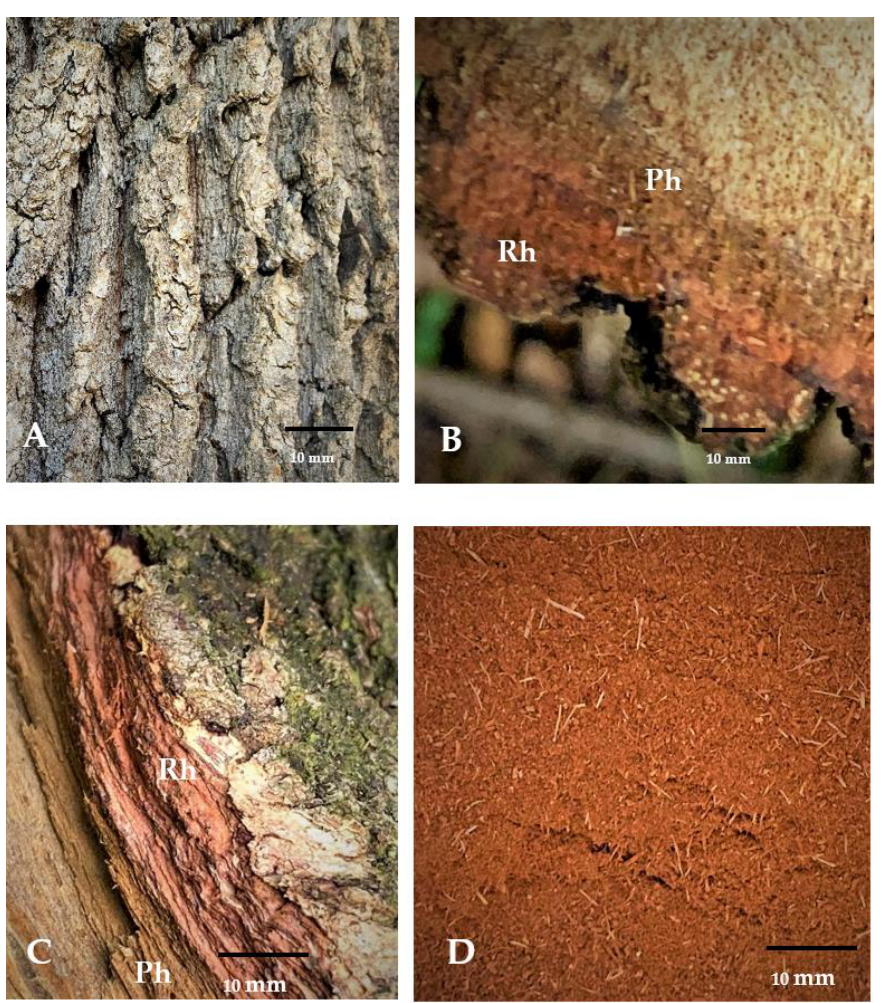
Figure 1. The bark structure of Quercus robur ( A ); General aspects of the transverse section, rhytidome (Rh) and phloem (Ph), ( B ); General aspects of the rhytidome in the fracture ( C ); General aspect of the powder after milling ( D ).